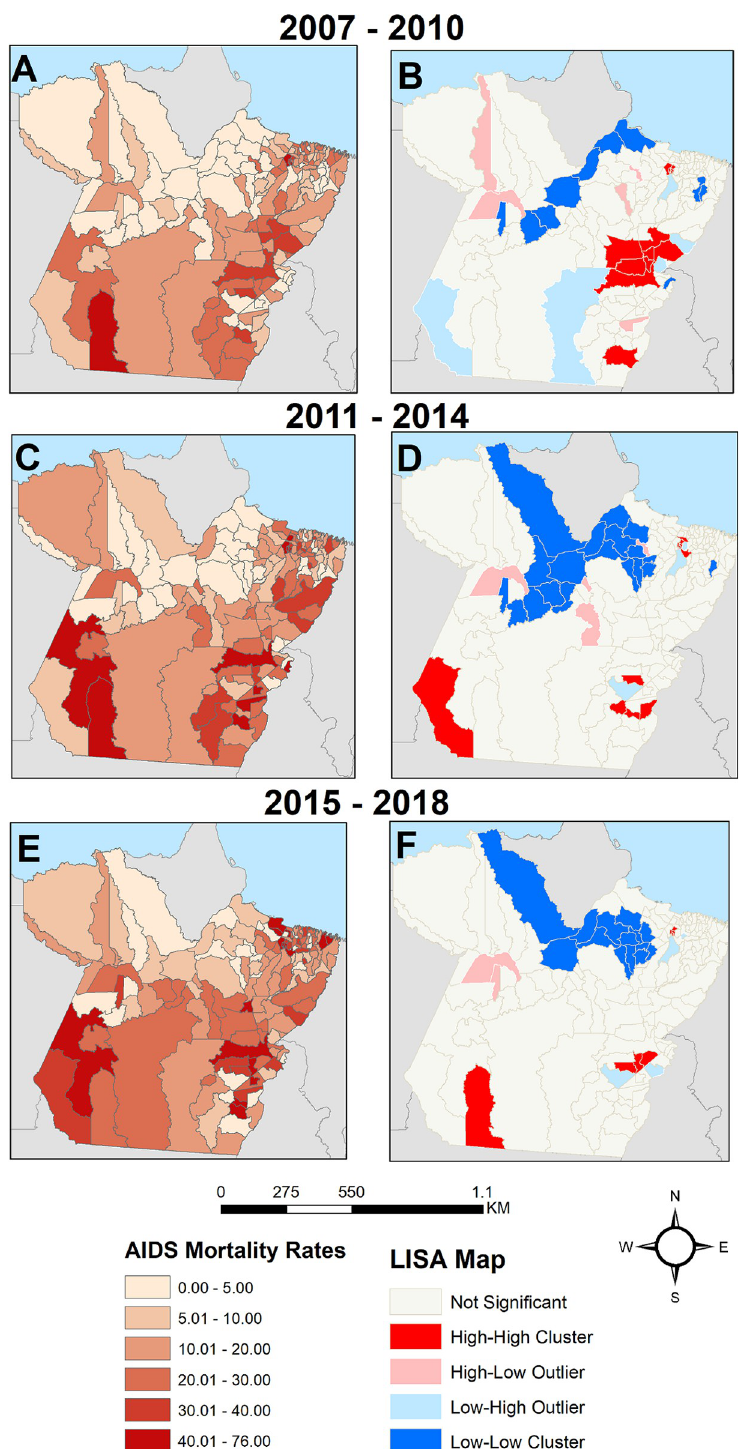
Fig 3. Spatial distribution and local Moran analysis of AIDS mortality rate standardized by age in Para´ from 2007 to 2018. A) Spatial distribution for 2007–2010; B) LISA map for 2007–2010, C) Spatial distribution for 2011–2014, D) LISA map for 2011–2014, E) Spatial distribution for 2015–2018, and F) LISA map for 2015–2018. Source: Authors.